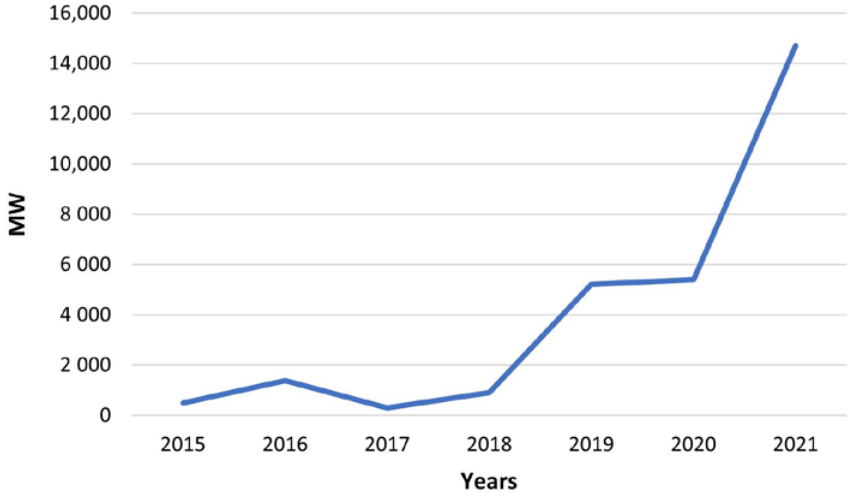
Figure 5. Installed capacity of rejected power plants (MW) in 2015 –2021.